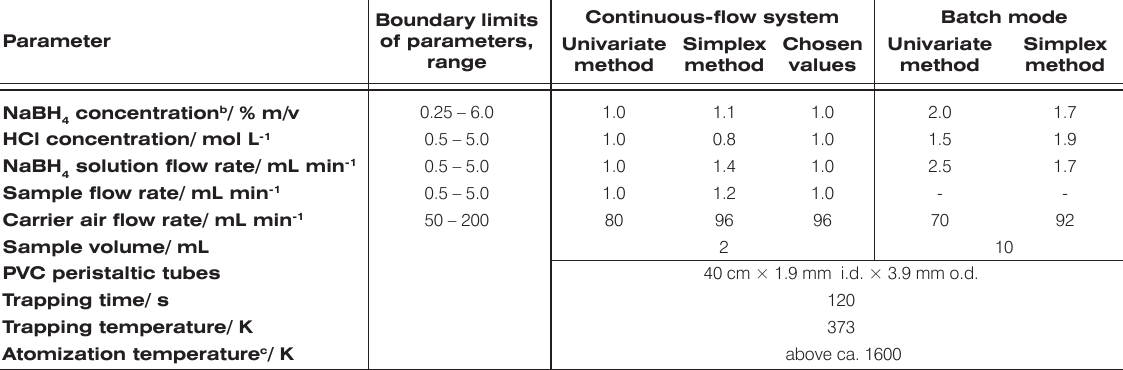
Table 2. Optimized operating conditions for determination of Ni by CVG-IAT-FAAS obtained by simplex and univariate methods a